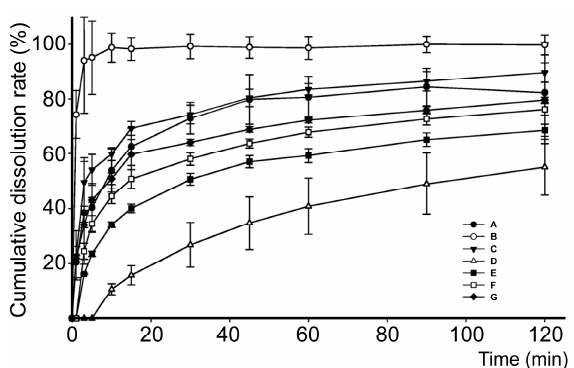
Figure 8. Dissolution profiles of F1 ( A ), F2 ( B ), F3 ( C ), PPD ( D ), PEG6000 PM ( E ), F68 PM ( F ), PEG6000 and F68 PM ( G ).